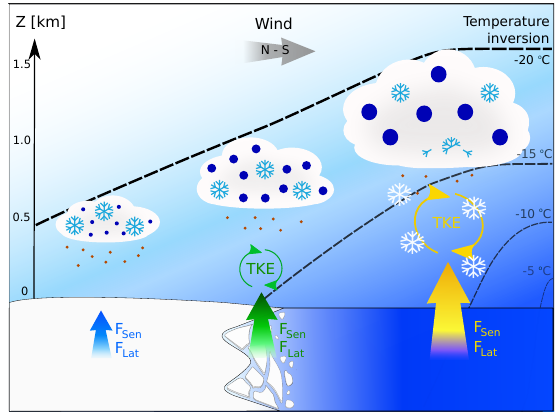
Figure 18. Schematic summarising the development of cloud mi- crophysical, aerosol, and thermodynamic properties across the tran- sition from sea ice to ocean. Aerosol particles, taken to represent the PCASP measurements, are illustrated as brown circles, and cloud droplets are similarly shown in blue. Cloud ice and snowflakes are shown as blue and white crystals respectively. The number of aerosol, droplet, and ice crystal symbols in each regime represents their number concentration in each case. Vertical arrows depict sen- sible and latent heat fluxes ( F sen , F lat ) from the surface, and in- crease in strength with size and from blue, through green, to yellow. Curled arrows represent the development of turbulent kinetic energy (TKE) below the clouds and their colour and size again represent the quantities measured. Temperature isotherms illustrate the changing BL structure over the transition from the cold sea ice to the warm